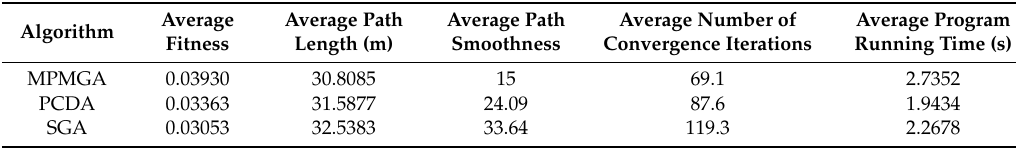
Table 4. Data comparison table of the three